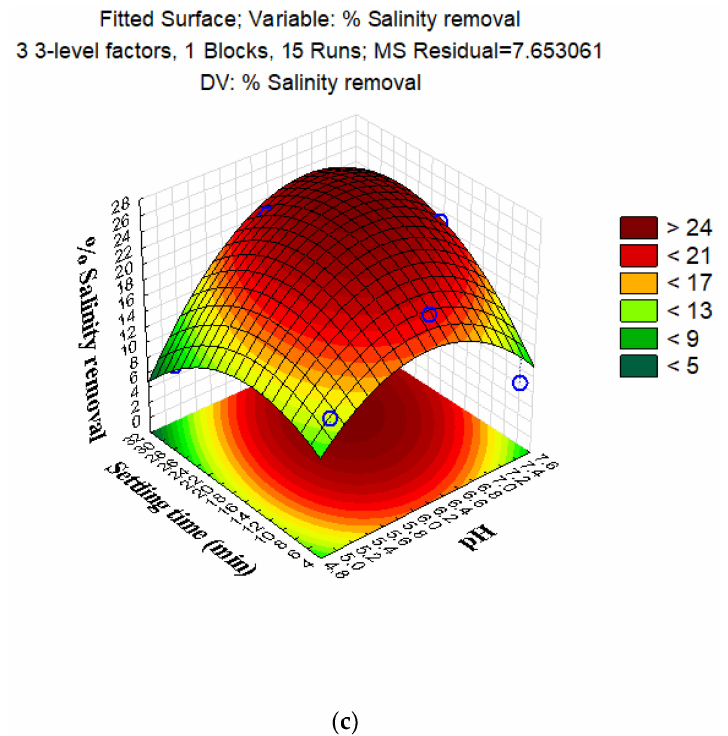
Figure 7. ( a ) Predicted and desirable % salinity removal using chitosan from carapace of M. rosenbergii. ( b ) Pareto chart for standardized effects of the independent factors and interactions for % salinity removal using chitosan from carapace of M. rosenbergii. ( c ) Three-dimensional fitted surface plots of % salinity removal using chitosan from carapace of M. rosenbergii